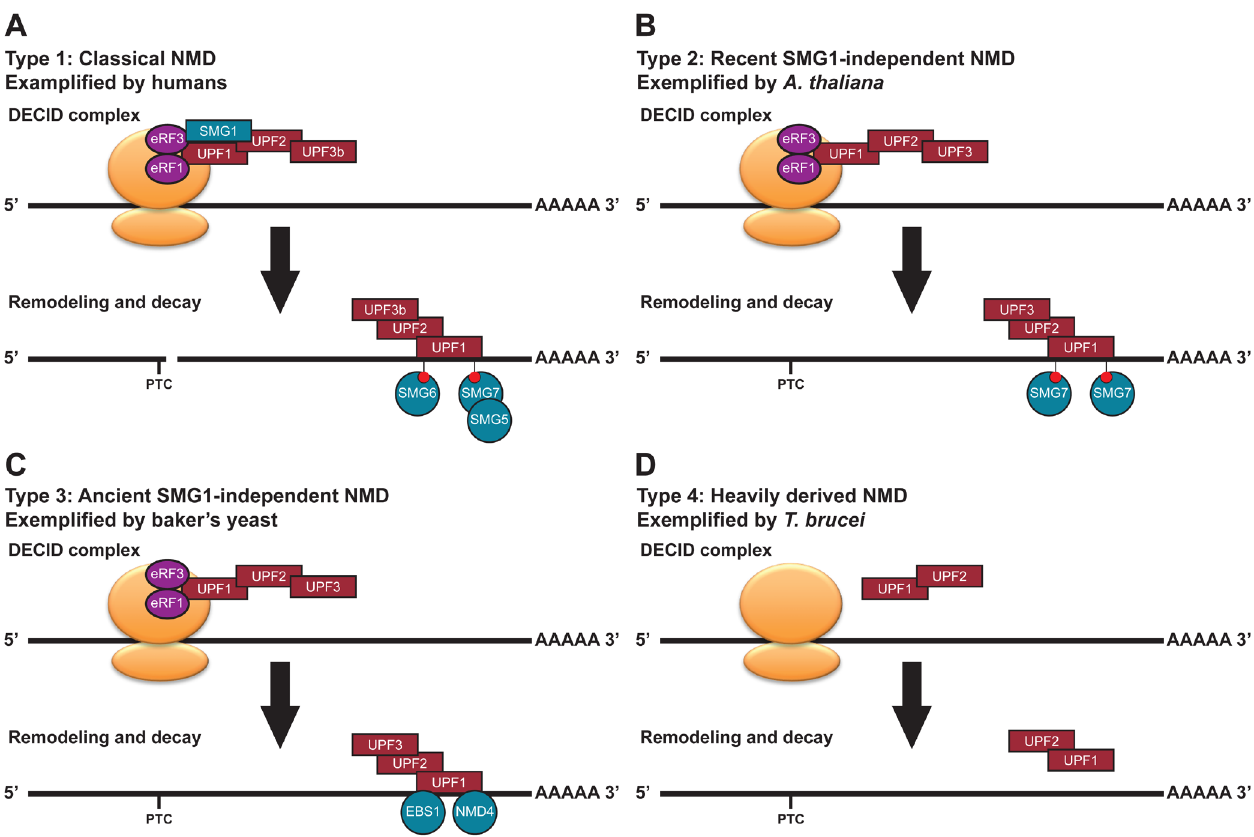
Figure 3. Models of evolutionarily diverse NMD pathways. ( A ) Classical NMD, exemplified by humans (modified from Figure 1). ( B ) Recent SMG1-independent NMD, exemplified by A. thaliana . A. thaliana lost SMG1 within the last 5–10 million years 45,51 . A. thaliana requires SMG7 for a functional NMD pathway 50 , retains a S/TQ rich UPF1 45 and its UPF1 needs to be phosphorylated to function in NMD in tobacco leaves 53,68 . This suggests an alternative kinase may have replaced SMG1. ( C ) Ancient SMG1-independent NMD, exemplified by baker’s yeast. The NMD pathway of baker’s yeast was the first to be characterised. UPF1, UPF2 and UPF3 have central roles in this pathway. Reverse genetics revealed a potential lesser role for EBS1, a SMG7 homologue, in NMD 60 but its UPF1 is depleted in S/TQ dipeptides 45 . ( D ) Heavily derived NMD, exemplified by T. brucei . It is unclear if a functional NMD pathway exists in these organisms. In T. brucei , it has been shown that UPF1 and UPF2 interact, but their interaction with the ribosome and potential NMD targets is unclear 43 . Tethering of UPF1 a transcript can decrease its abundance 43